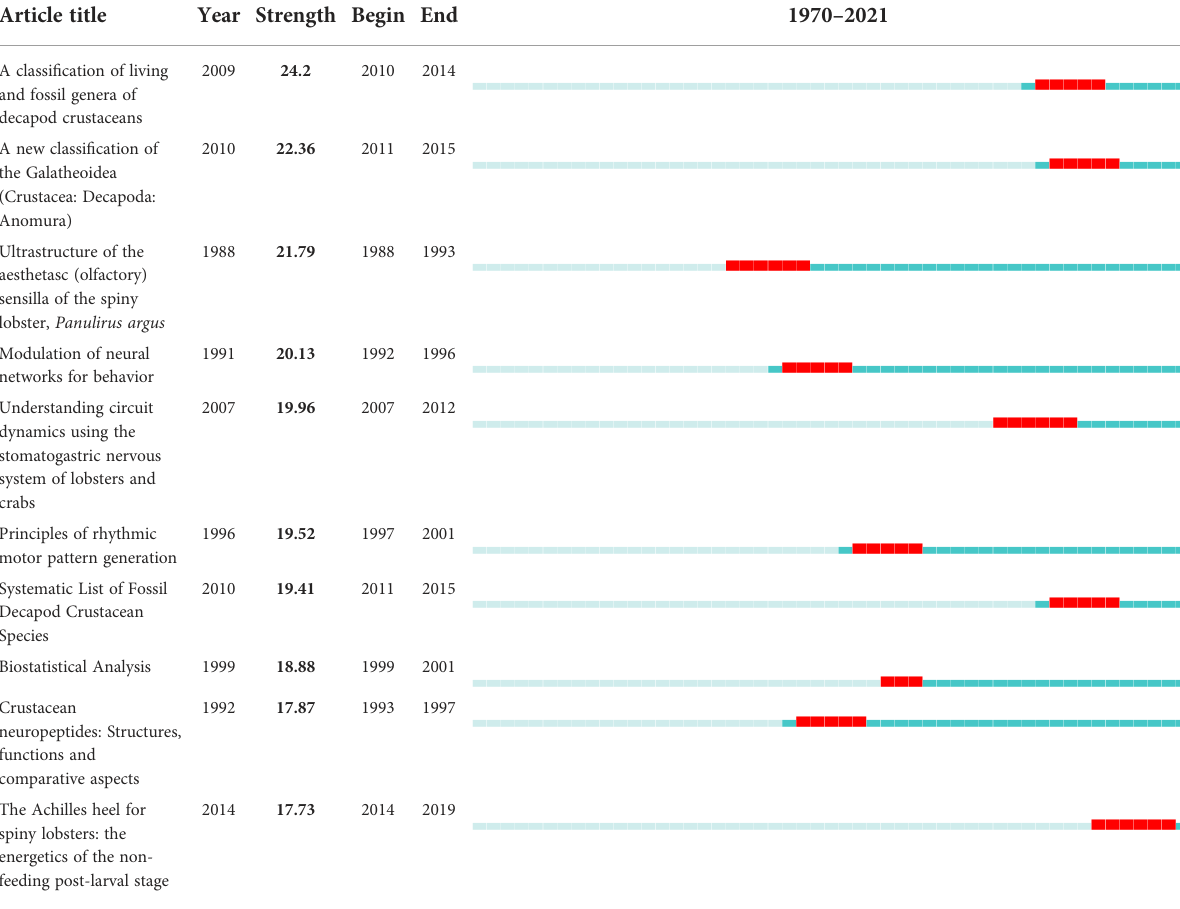
TABLE 5 Top 10 publications with the strongest citation burst in marine lobster research between 1970 and 2021.